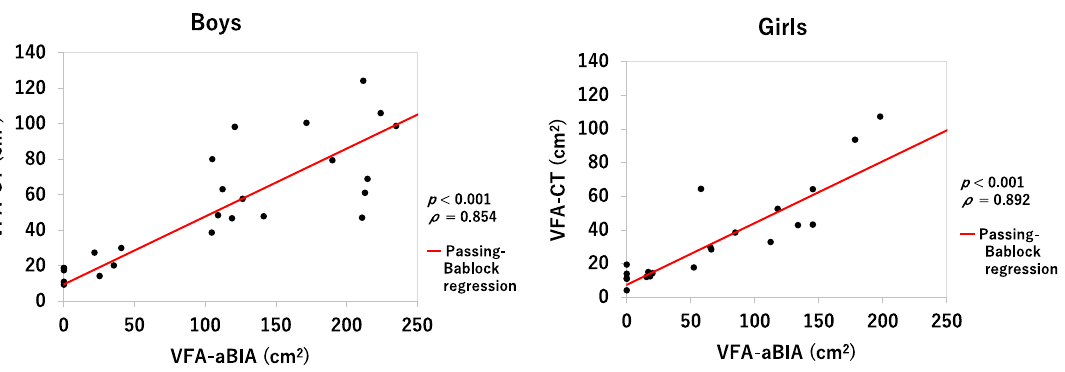
0.3825x (boys) and y = 7.607 + 0.3661x (girls). The value of y calculated by substituting the measured value (x’) of VFA-aBIA of each subject into x of the above linear relational ex- corrected VFA-aBIA minus VFA-CT was − 2.2 ± 38.2 (cm 2 ) in boys and − 2.4 ± 26.2 (cm 2 ) pression was taken as the correlated VFA-aBIA. in girls, respectively, indicating that the precision in girls was better than that in boys.